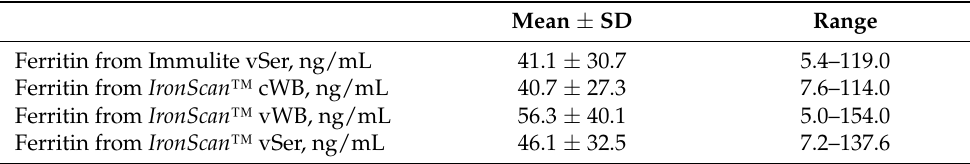
Table 2. Ferritin values and ranges across devices and blood sampling methods 1 .